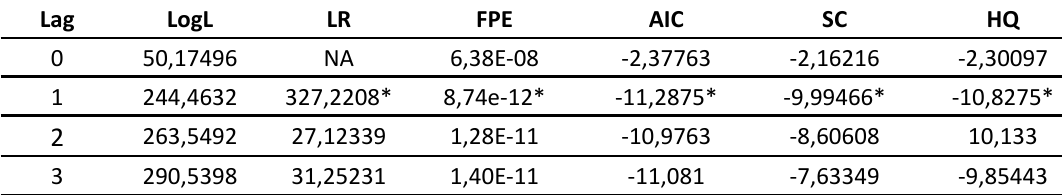
Table 2: Lag Optimum